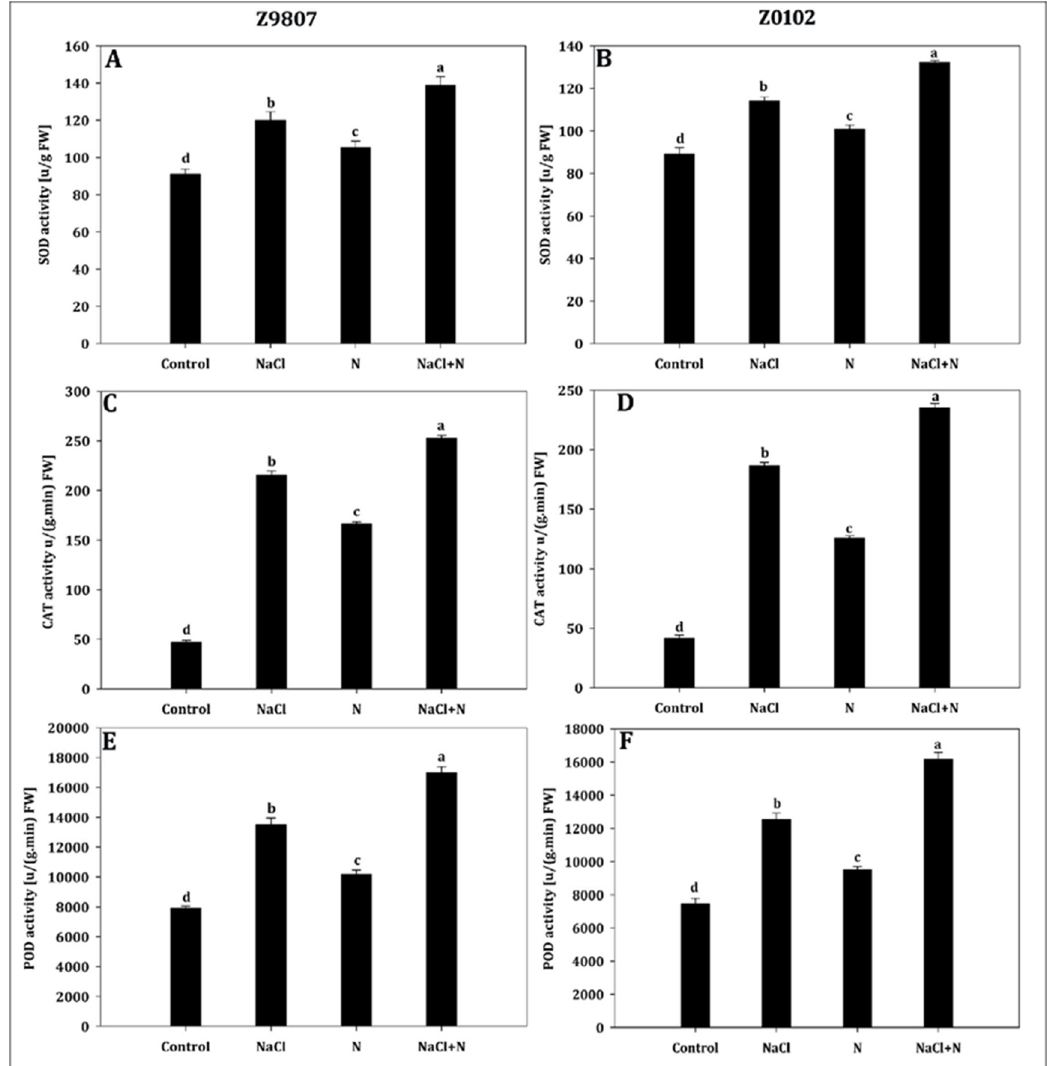
Figure 8. Effect of nitrogen supplementation on ( A , B ) superoxide dismutase, ( C , D ) catalase, and ( E , F ) peroxidase in Gossypium hirsutum L. under salinity stress. Data represent the mean of three replicates and bars with different letters denote significant differences at p < 0.05.